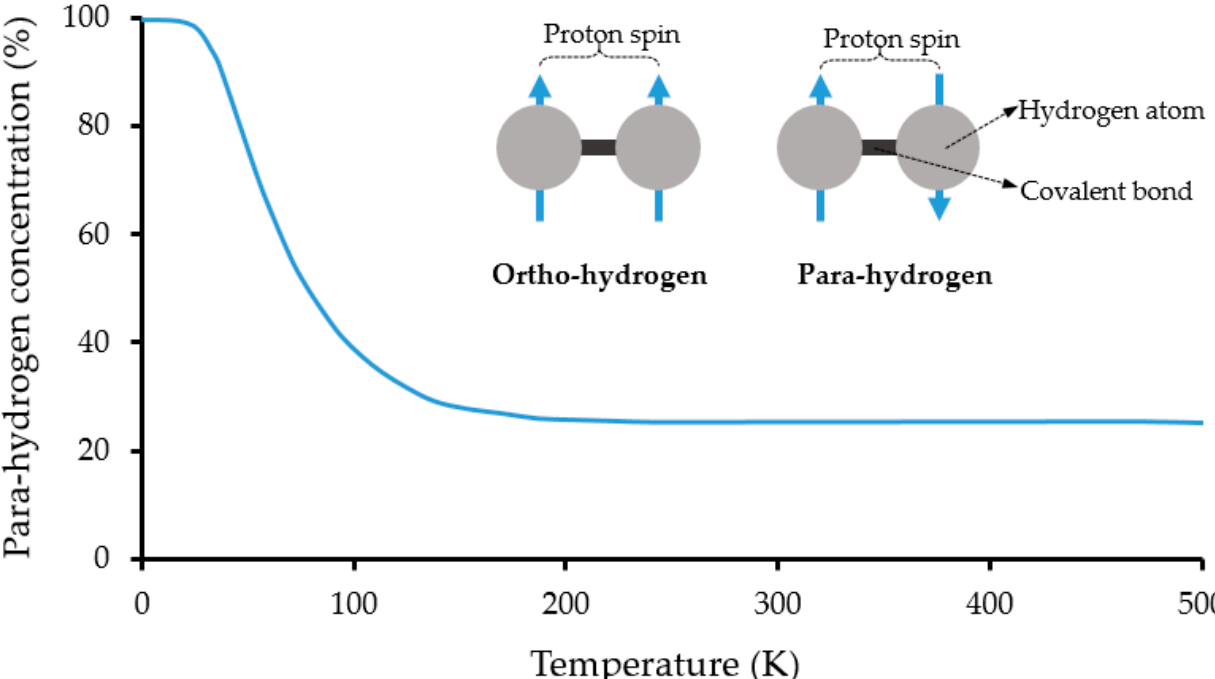
Figure 4. Spin isomers of molecular hydrogen and its para-hydrogen concentration in equilibrium hydrogen for each corresponding temperature [61]. Table 4. Characteristics comparison of ortho- and para-hydrogen [62].